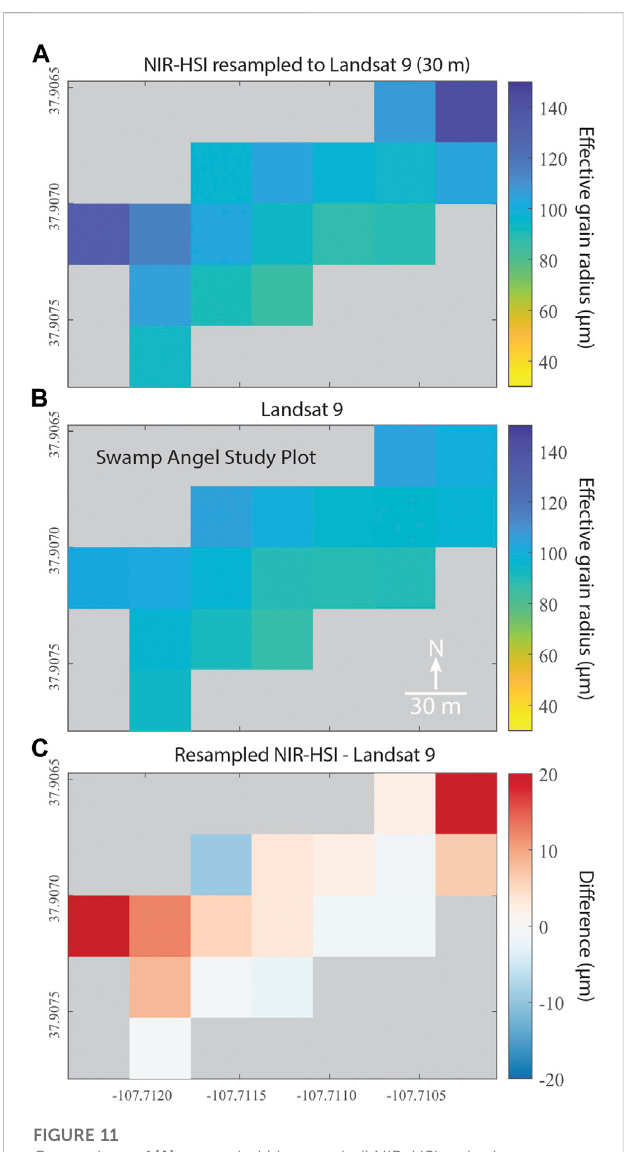
FIGURE 11 Comparison of (A) resampled (downscaled) NIR-HSI grainsize map to (B) Landsat 9 OLI NDGSI map, with the difference map shown in (C) .